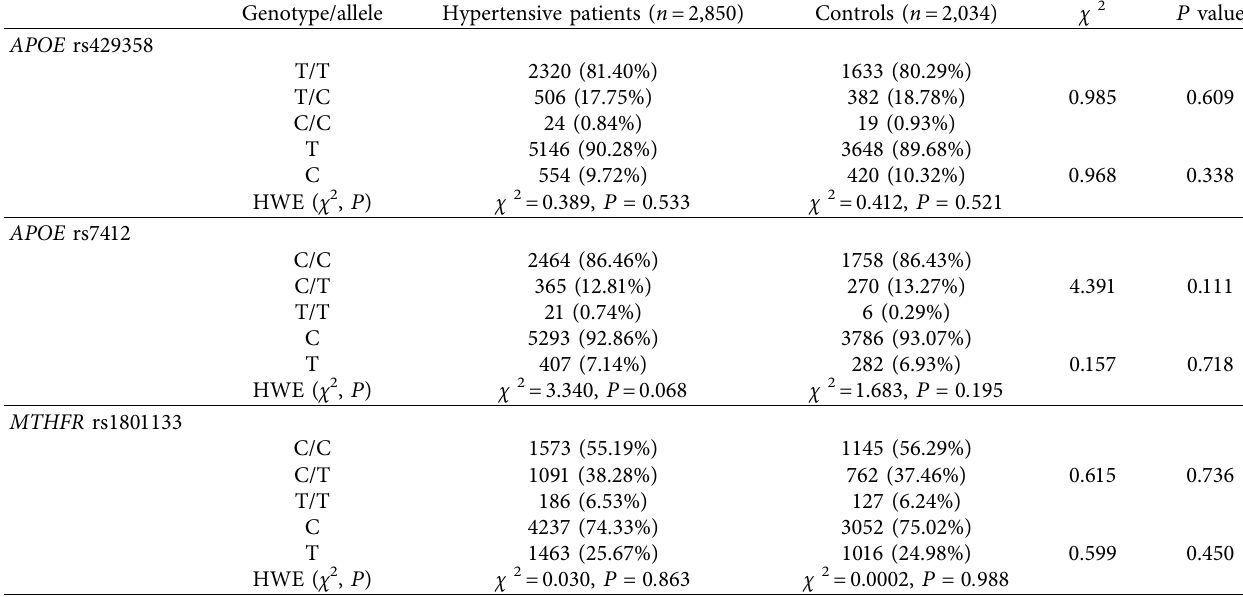
Table 2: Frequencies of APOE rs429358, rs7412, and MTHFR rs1801133 genotypes and alleles in hypertensive patients and